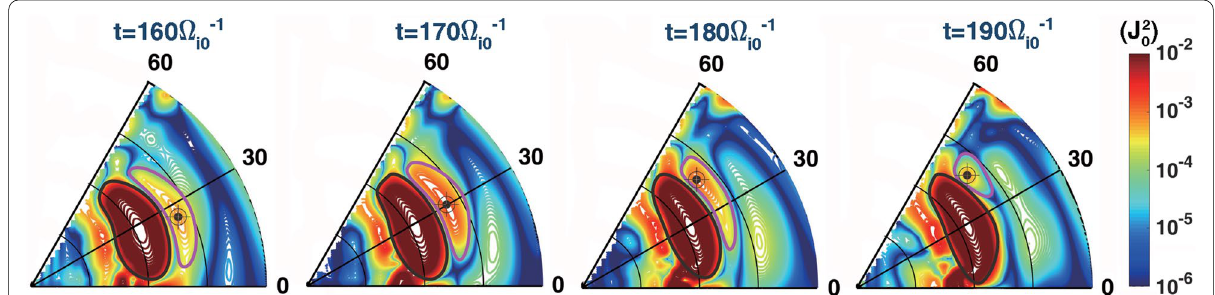
1 (cid:31) − 1 (cid:30) in northern hemisphere at r = 4 R E from t = 160 (cid:31) − i 0 to t = 190 i 0 . || 6 8 R E is tracked with purple circles with their ∼ −